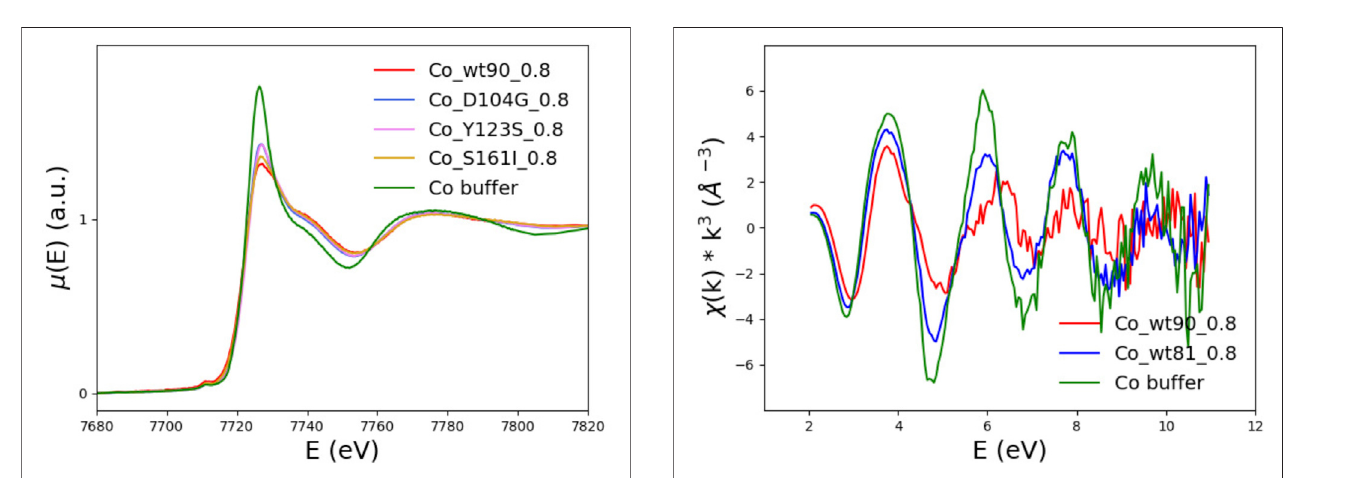
FIGURE7| TheXANESspectraoftheD104G(blue), Y123S(violet),and S161I (gold) variants are plotted together with the wt-FXN (red) and the buffer (green) spectra.